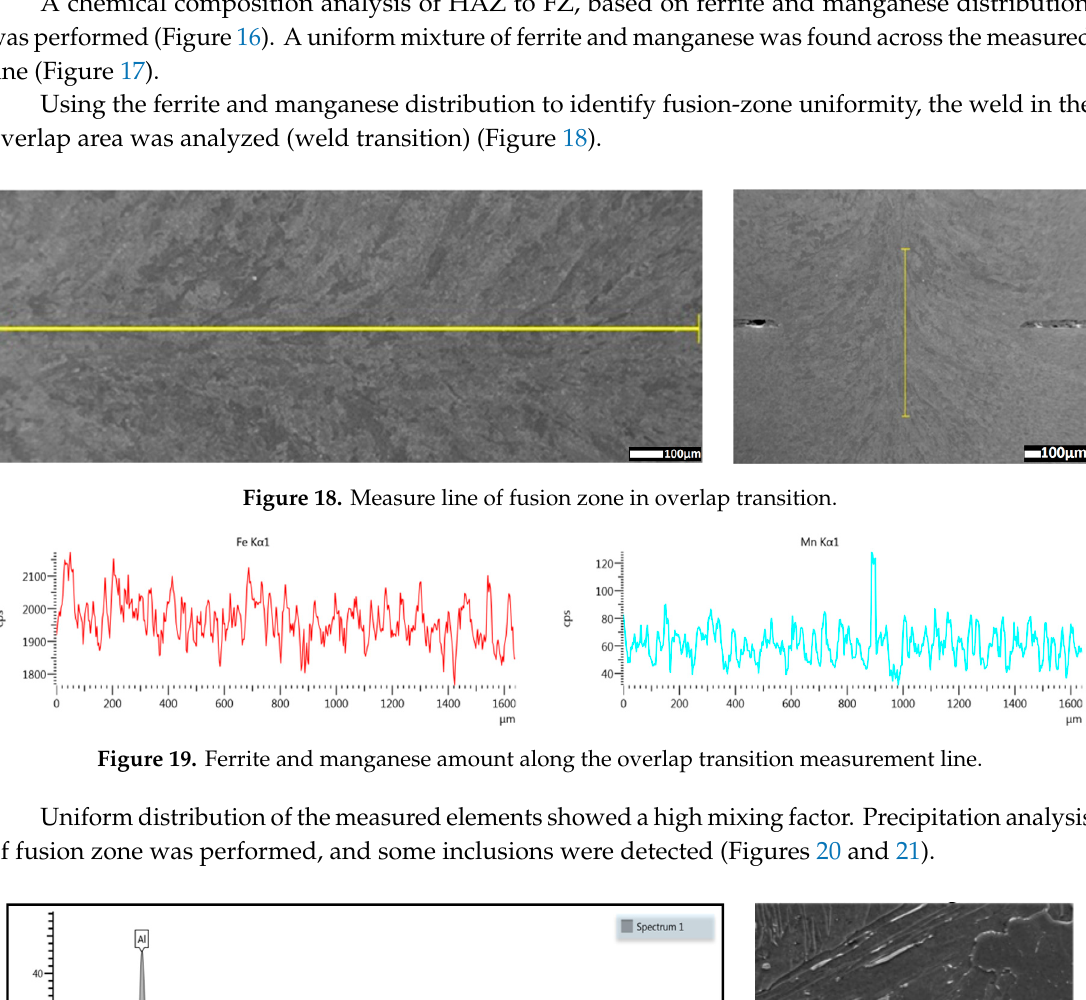
Figure 19. Ferrite and manganese amount along the overlap transition measurement line.